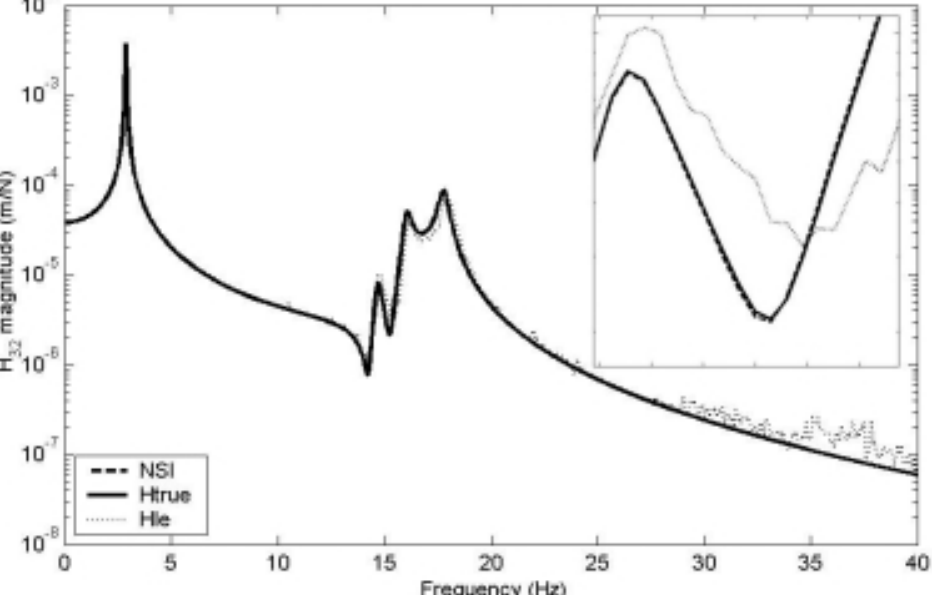
Fig. 3. H 32 system receptance: nominal linear FRF (solid line), NSI nominal linear estimate (dashed line) and FRF estimated by linear methods (Hle, dotted line, mean value between H 1 and H 2 procedures).